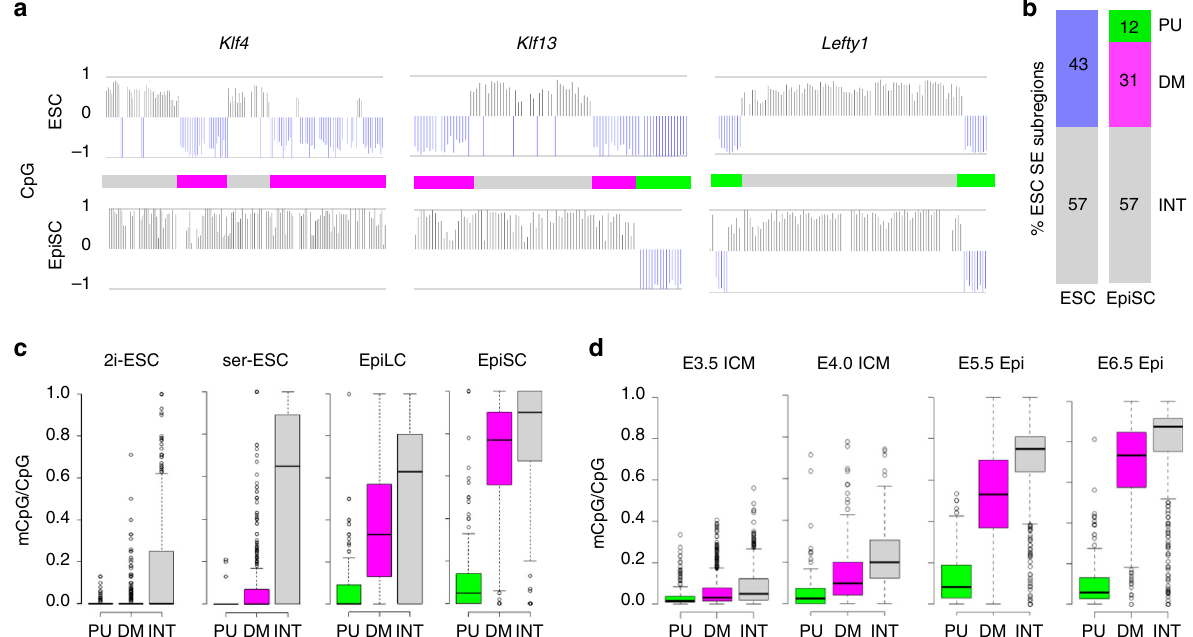
Fig. 2 ESC SEs acquired CpG methylation in different patterns as primed pluripotency is established. a CpG methylation along three representative SEs in embryonic stem cells (ESCs; serum/LIF) 11 and epiblast stem cells (EpiSCs; this study) in CDM supplemented with activin A and fi broblast growth factor 2 as represented in Fig. 1a. Unmethylated SE subregions that gain methylation in EpiSCs are represented as magenta bars (DM subregions), and those that remain unmethylated as green bars (PU subregions). Grey bars represent interstitial (INT) regions in ESCS that remain methylated in EpiSCs. b Proportion (%) of SE subregions in ESCs and EpiSCs. Unmethylated regions in ESCs (blue bar) either remain unmethylated (PU, green, 184 subregions) or become methylated (DM, magenta, 492 subregions) in EpiSCs; INT (547 subregions) methylated regions are shown in grey. A total of 231 SEs were analysed. c CpG methylation levels (mCpG/CpG) at PU, DM and INT subregions in an independent ESC line grown in serum/LIF (ser) 14 , in EpiLCs and an independent EpiSC line 23 . ESCs grown in 2i/LIF (2i) 11 are also shown; 2i/LIF conditions enforce a globally hypomethylated state of genome. d CpG methylation levels (mCpG/CpG) at PU, DM and INT subregions in vivo in pre-implantation (inner cell mass (ICM); E3.5 and E4.0) and post-implantation epiblast (Epi; E5.5 and E6.5) tissues 22 enhancer units within SEs partition as constitutively hypomethy- Fig. 3f, g). Class I (light green) and class II (pink) SE-associated lated (PU) or decommissioned (DM) during the pre- to post- genes showed comparable expression levels in ESCs (Supplemen- tary Fig. 4f). Correlating with the presence of PU units, class I